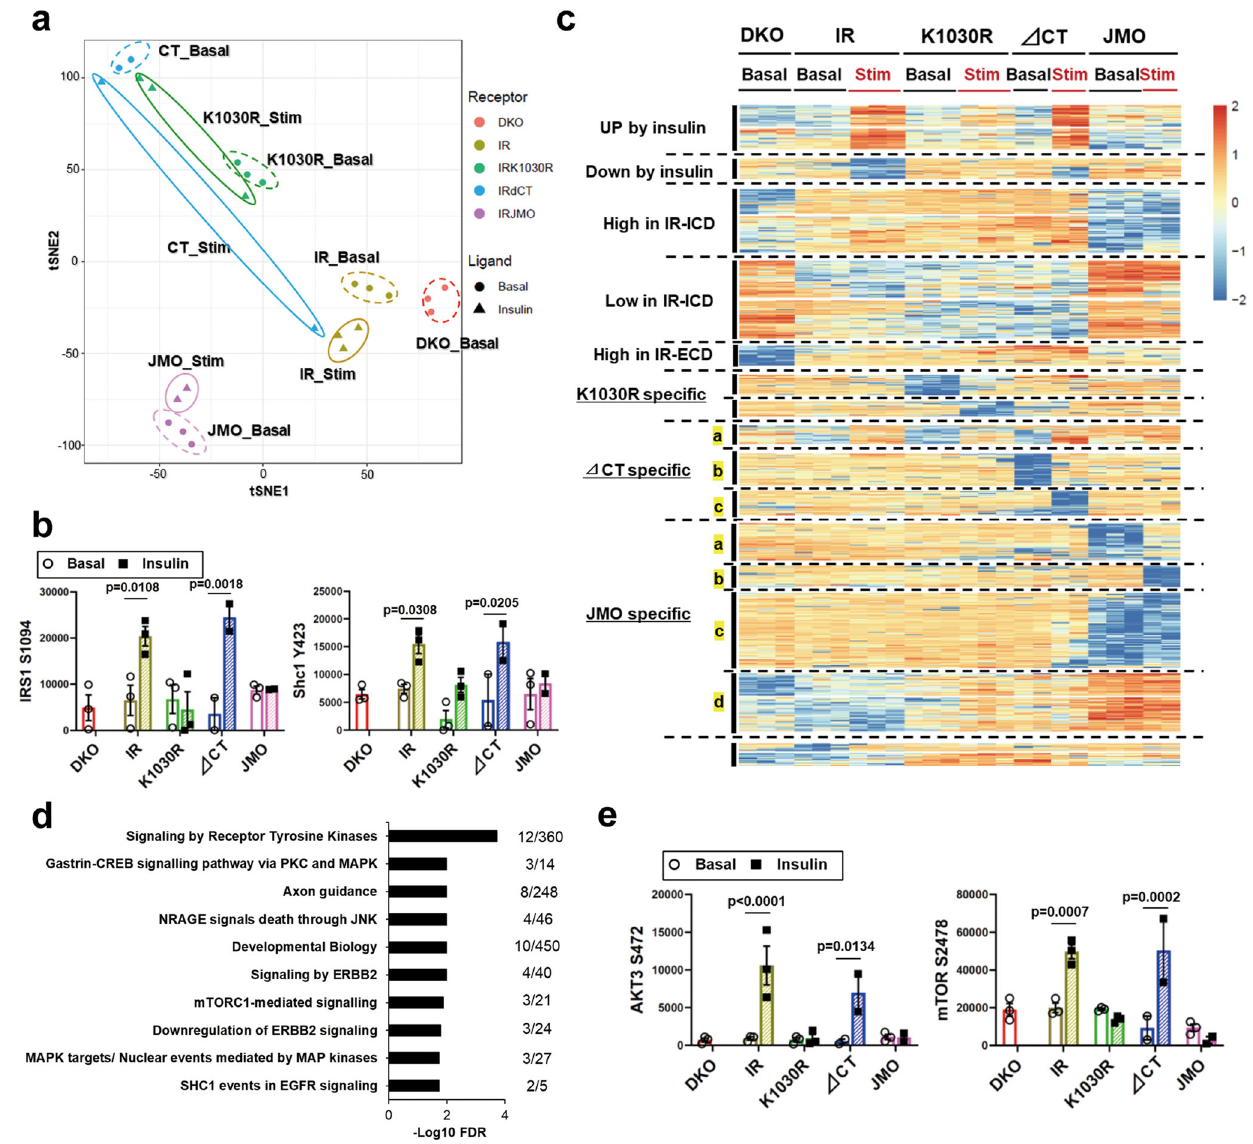
Δ CT,andJMOcellsinthebasalandinsulin-stimulatedstates.Valuesare Z -scoresof log2 transformed intensity values. d REACTOME pathway enrichment analysis of phosphosites in the Up by Insulin cluster. The functional enrichment analysis was tested by the STRING database, where FDRs were calculated using the Benjamini – Hochberg procedure. Plots are − log10 transforms of enrichment FDR value. e Quantitation of exemplary phosphosites in the Up by Insulin cluster. Data aremeans±SEMofphosphositesintensityvalues(×10 4 )( n =2 – 3). P -valuesarebasal vs insulin, two-way